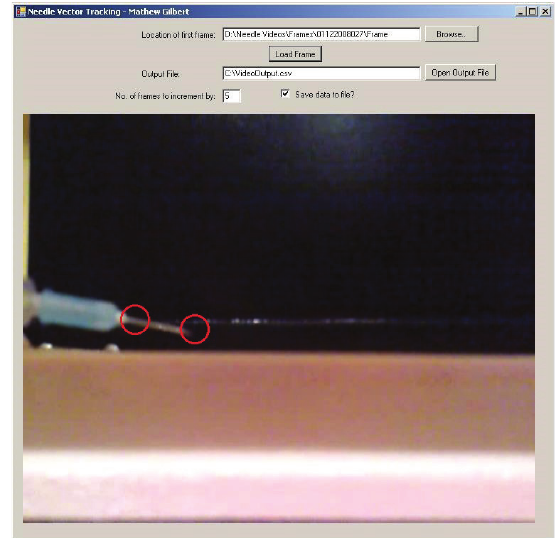
Figure 12: Needle vector tracking software for tracking the motion of the needle during VP. The points circled (red) were used for the velocity and angle profiles shown in Figures 13 and 14.